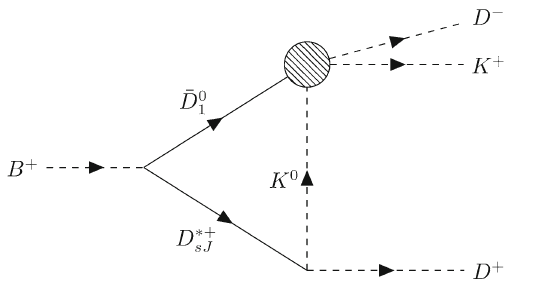
Fig. 4 Triangle diagram of the process B + → D + D − K + . The shadow circle represents the production vertex of X 1 ( 2900 )